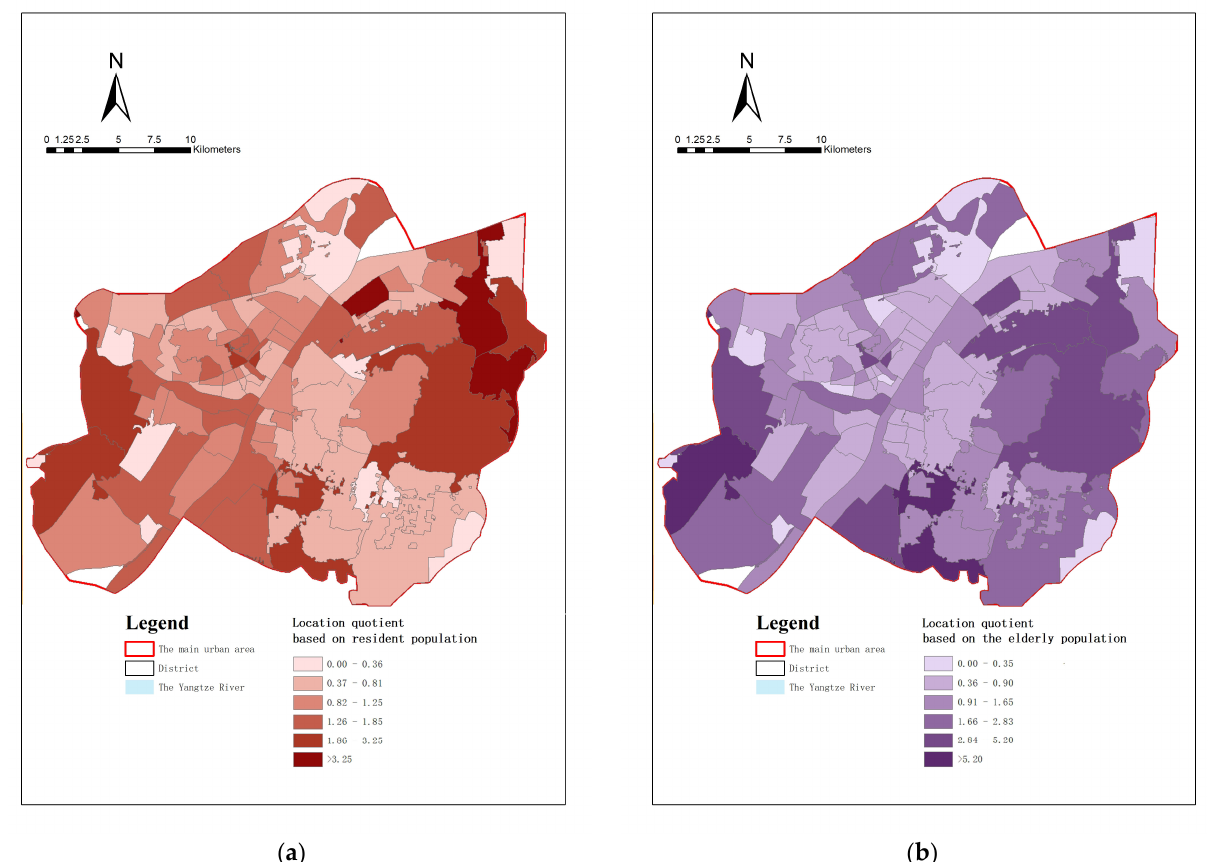
Figure 9. ( a ) The location quotient based on resident population; ( b ) The location quotient based on the elderly population.